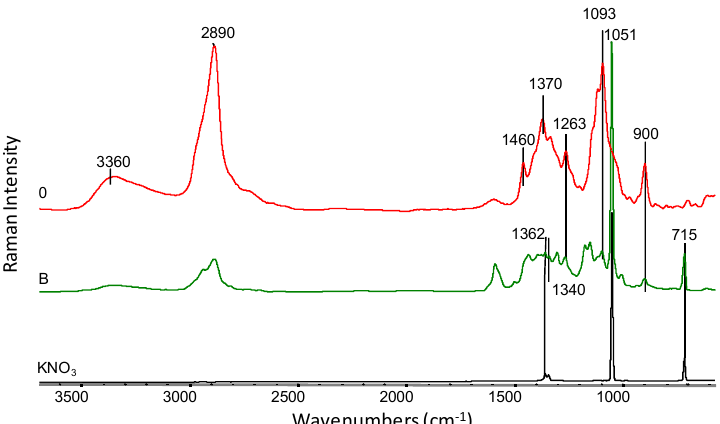
Figure 9. FT-Raman spectra in the range of 3700–500 cm − 1 for: 0—viscose nonwoven, B—KNO 3 - modified nonwoven and pure potassium nitrate crystals (KNO 3 ).